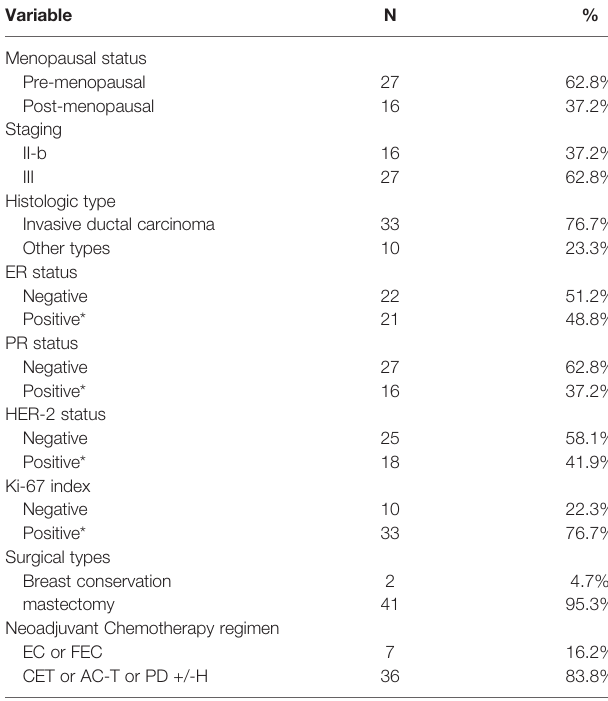
TABLE 1 | Baseline clinical characteristics of all